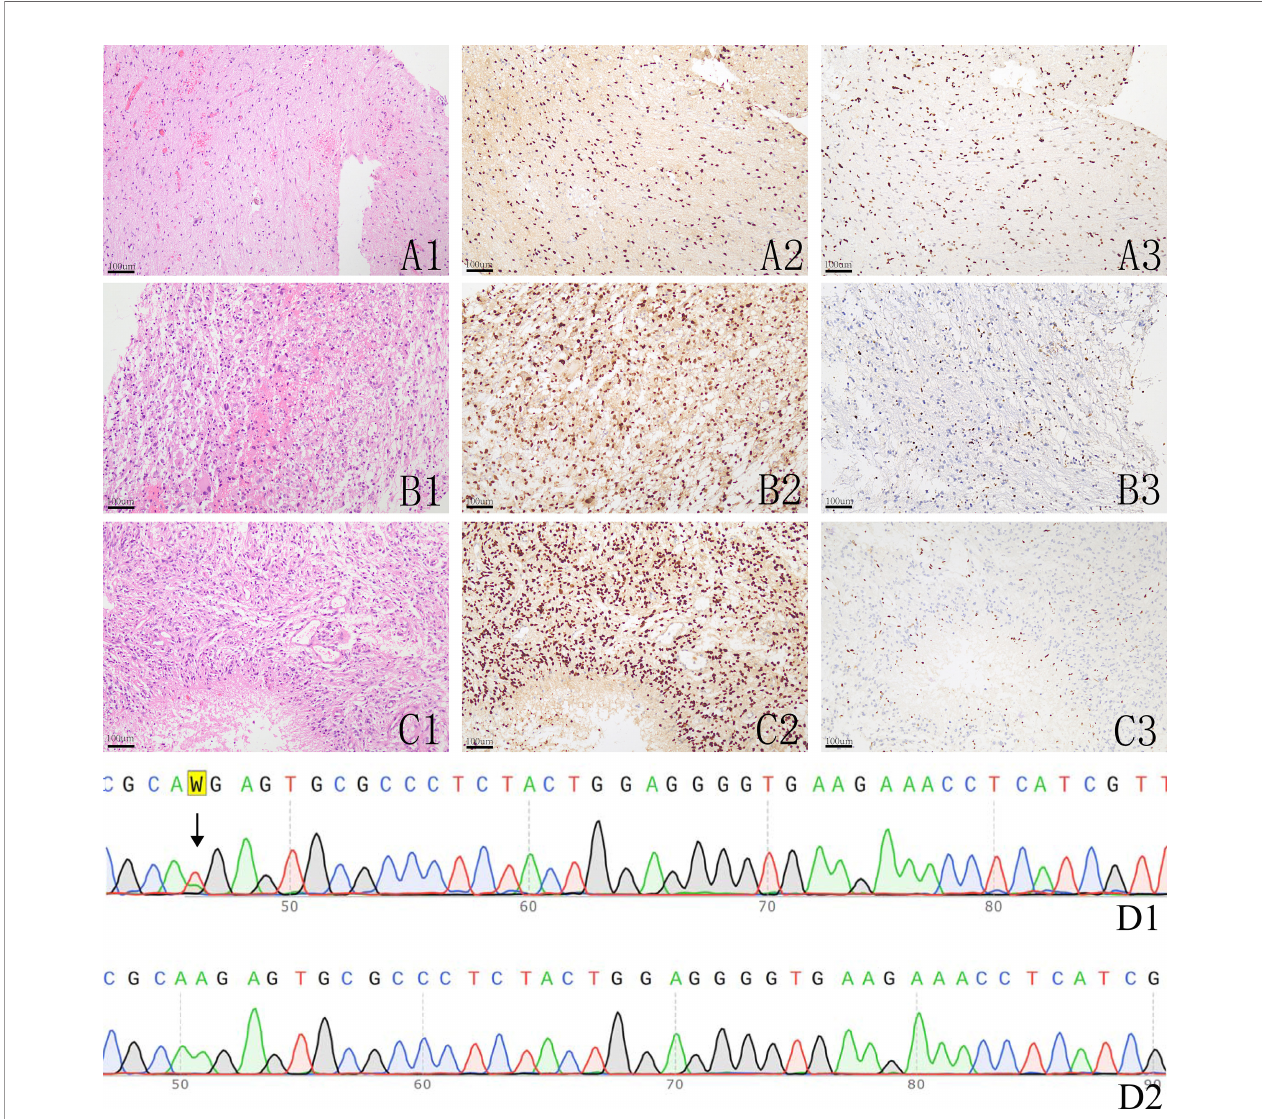
FIGURE 2 | The histological image and immunohistochemistry results of H3K27M and H3K27me3, A1-A3 : a histologically grade 2 glioma showing H3K27M expression (A2) and downregulation of H3K27me3 (A3) ; B1-B3 : a histologically grade 3 glioma showing H3K27M expression (B2) and slightly downregulation of H3K27me3 (B3) ; C1-C3 : a histologically grade 4 glioma showing H3K27M expression (C2) and loss the expression of H3K27me3 (C3) ; D1-D2 : Sanger sequencing of H3F3A in one H3K27M mutant glioma showing A > T mutation (D1) and a H3K27M wild glioma (D2)